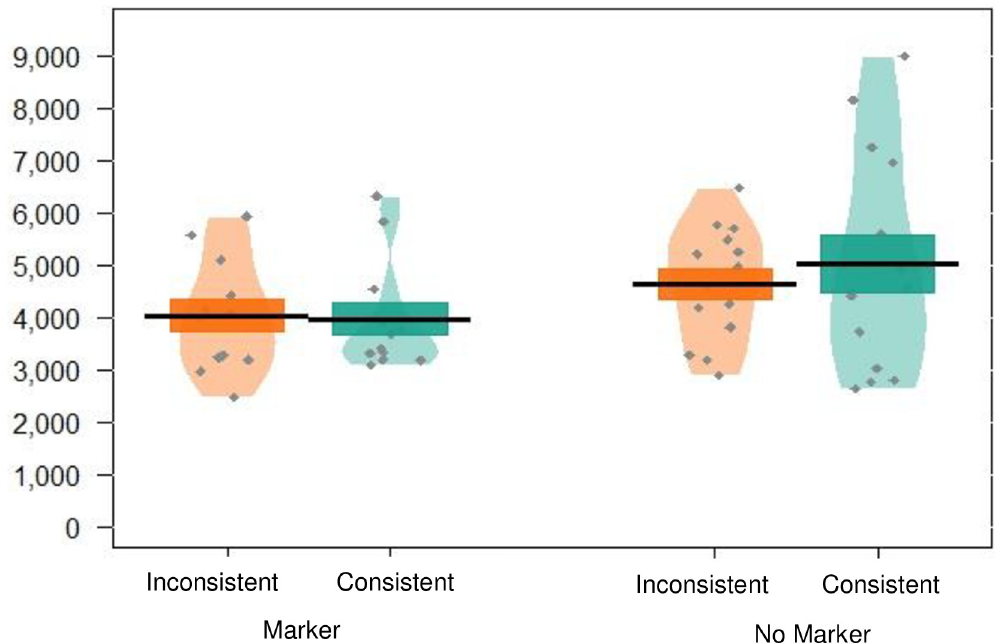
Fig 6. Pirate plot depicting the mean (raw) looking times to trials containing words from the same versus different categories for each condition. Black lines indicate the mean, and the coloured blocks indicate SE . The distribution of looking times is given for each group, with individual data points in